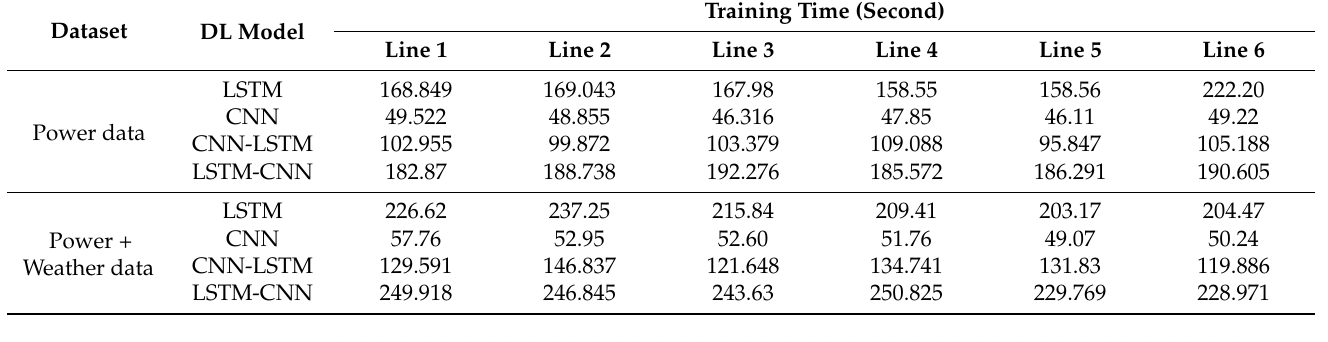
Table 6. Training time of the deep learning models.